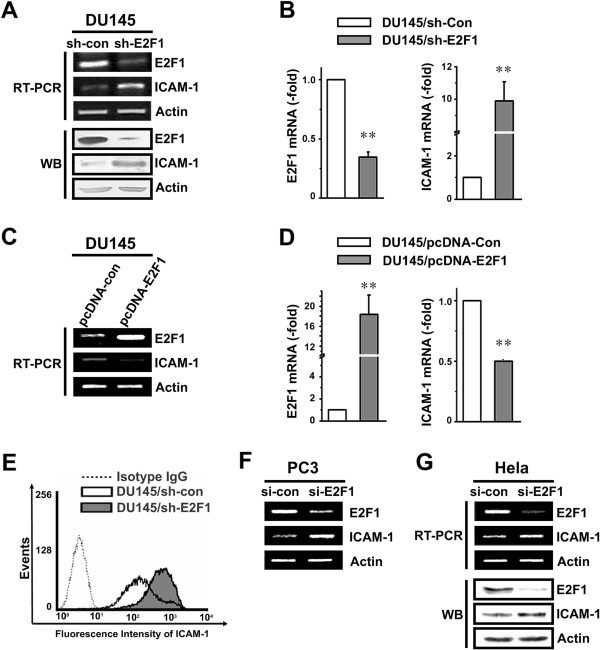
Expression of ICAM-1 is highly inversely correlated with E2F1 expression. A. ICAM-1 expression in DU145 cells. Whole cell lysates or total RNA were prepared from DU145 cells stably transfected with either the control vector or shRNA targeting E2F1. The expression of E2F1 and ICAM-1 was monitored by RT-PCR (upper) and Western blot (lower). B. ICAM-1 expression in DU145 cells was analyzed by real-time PCR. The stars indicate the significant differences (P < 0.05). C. E2F1 overexpression plasmids or control were transient transfected to DU145 cells in a 6-well plate for 48 h. The expression of E2F1 and ICAM-1 were measured by RT-PCR. D. The expression of E2F1 and ICAM-1 was measured by real time PCR. The stars indicate the significant differences (P < 0.05). E. Membrane expression of ICAM-1 in DU145/sh-E2F1 and control cells was measured by FACS. F. siRNA of E2F1 or scramble control was transient transfected to PC3 cells in a 6-well plate for 48 h. The expression of E2F1 and ICAM-1 in these cells were measured by RT-PCR. G. Forty pmol duplex siRNA of E2F1 or scramble control was transient transfected to Hela cells in a 6-well plate for 48 h. The expression of E2F1 and ICAM-1 in these cells were measured by RT-PCR (upper) and Western blotting analysis (lower).